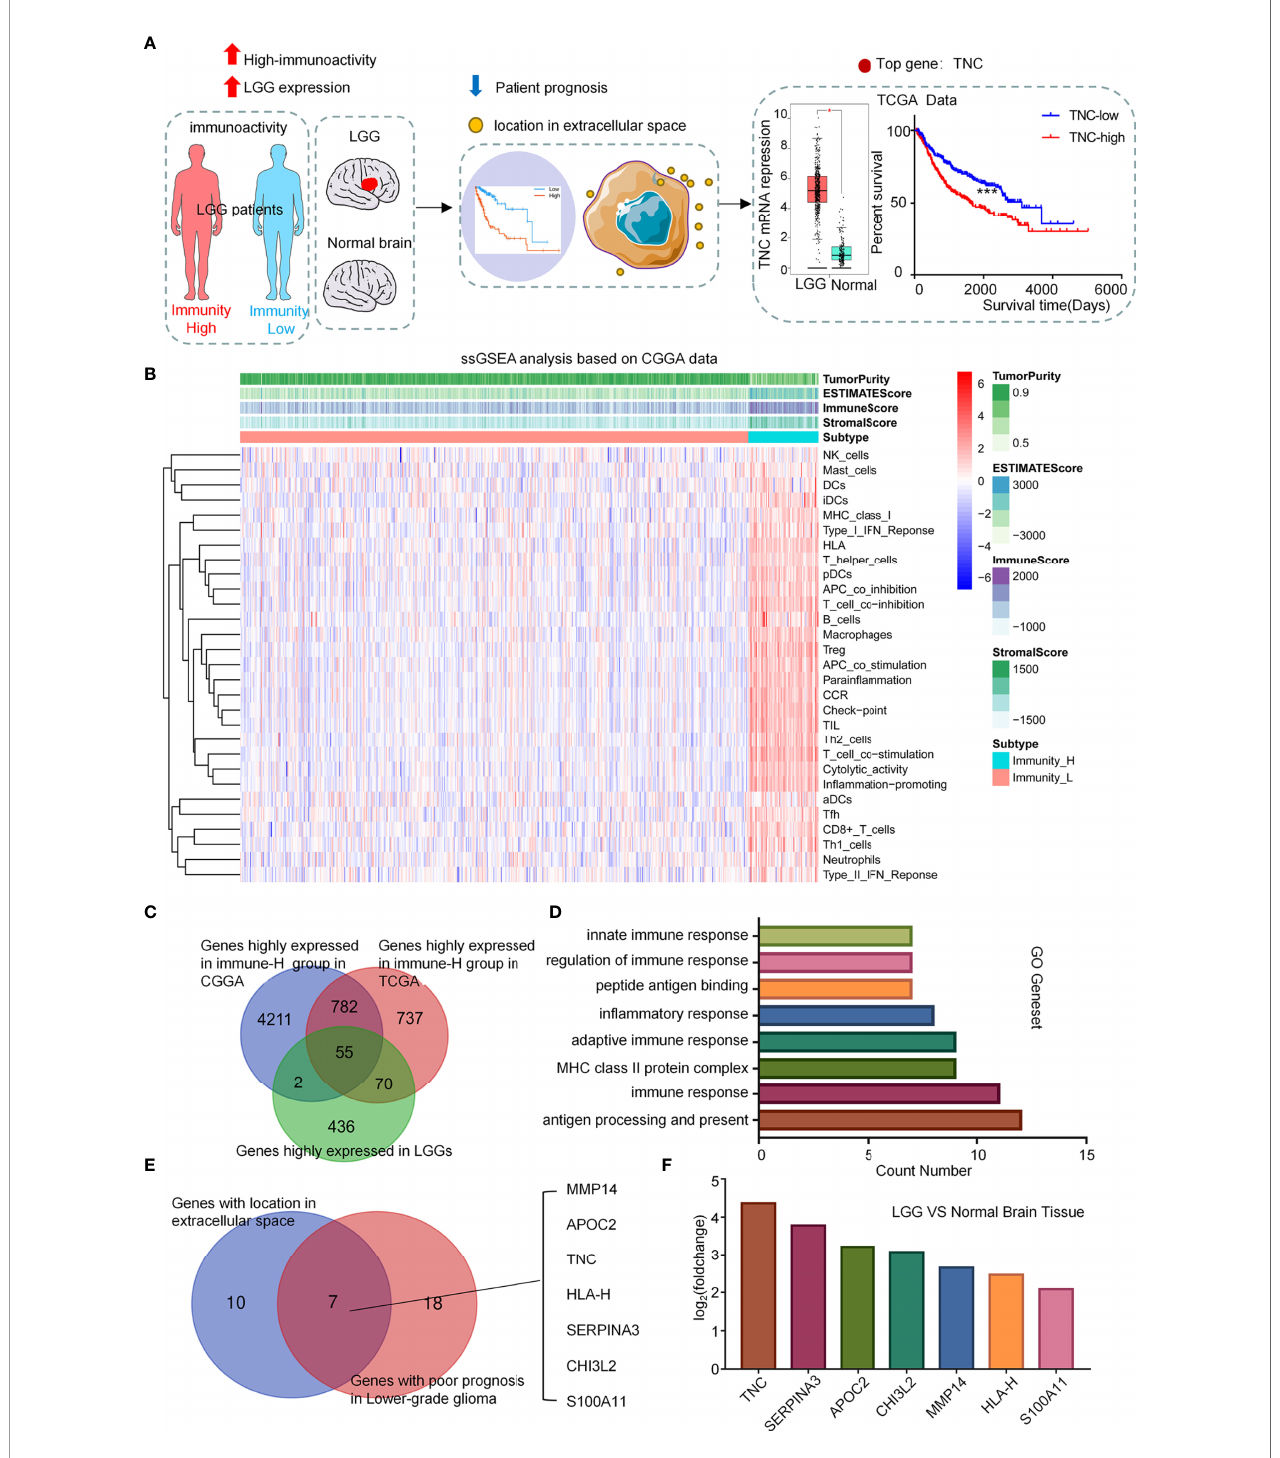
FIGURE 1 | Screening of related genes for predicting immune microenvironment in LGGs. (A) Diagram showing the bioinformatical strategies to identify candidates that can re fl ect the status of LGG immune microenvironment and predict the prognosis. (B) Clustering heatmap based on ssGSEA scores of 29 immune-related gene sets in CGGA database. (C) Venn diagram showing genes that were highly expressed in both the immunity-high subgroup and LGG patients. (D) Functional gene-set enrichment analysis of 55 genes selected in (C) . (E) Venn diagram showing the intersection between the genes located in extracellular space and the genes related to poor prognosis in LGGs as calculated by the Log-rank test. (F) Immune-related target genes ranked in terms of relative gene expression level (LGGs vs . normal brain